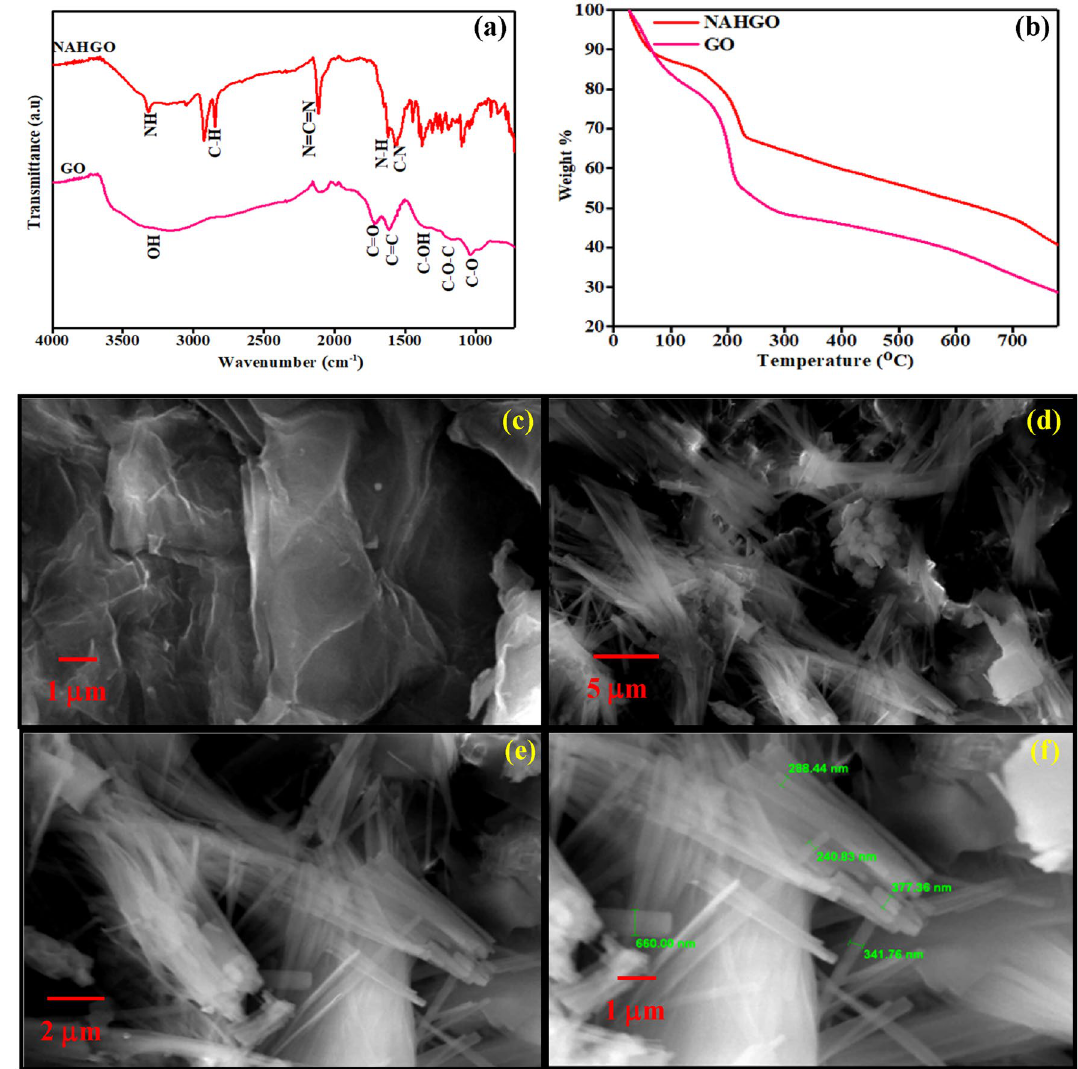
Figure 2. ( a ) FTIR spectra, ( b ) Thermogravimetric analysis, ( c ) SEM images of GO, and ( d – f ) NAHGO in different